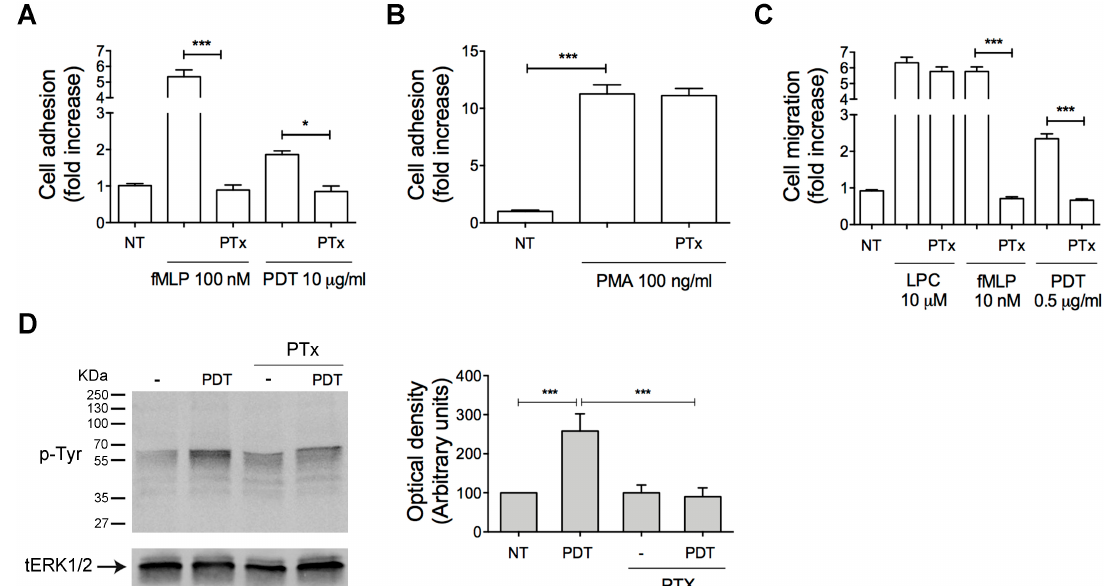
Figure 3. Effect of PTx on PDT-induced monocytes adhesion, migration and protein tyrosine phosphorylation. (A, B) Static adhesion assay of monocytes on ICAM-1. Cells pretreated with 500 ng/mL of PTx for 2 h at 37 °C were stimulated for 2 min at 37 °C with PBS (NT), fMLP (100 nM), PDT (10 μ g/mL) ( A ) or for 10 min with PMA (100 ng/mL) ( B ). Bars represent the means ± SD of